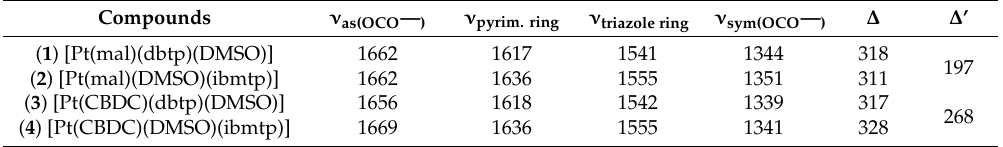
Table 4. IR spectroscopic data for platinum(II) complexes (in cm − 1 ). Compounds ν as(OCO—) ν pyrim. ring ν triazole ring